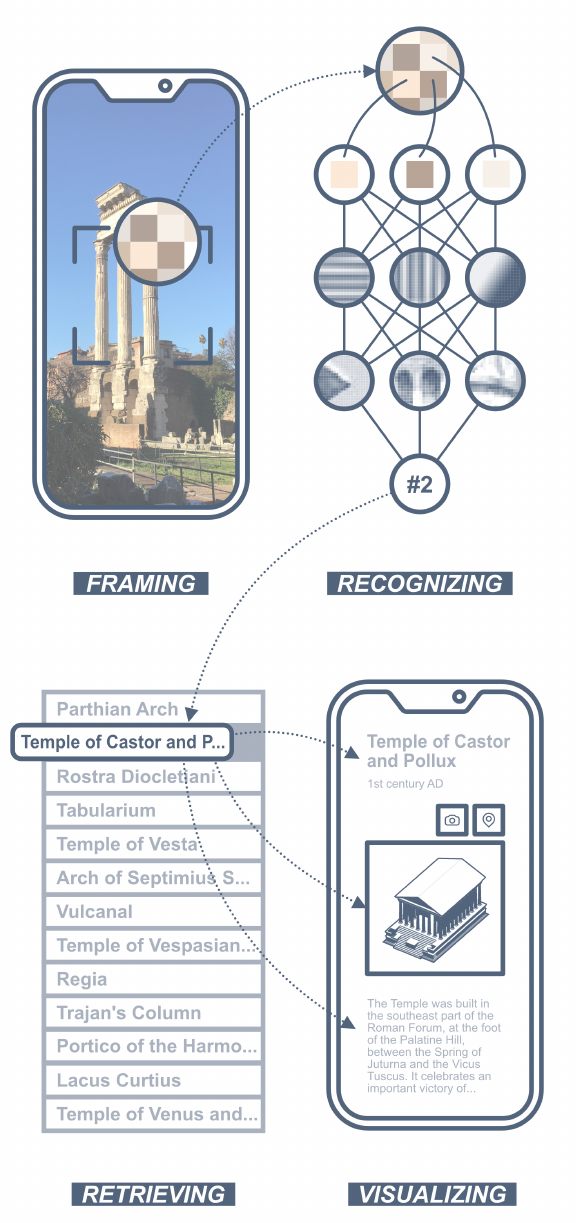
Figure 7. Scheme of the connection between the main view of the app interface and the monument detail